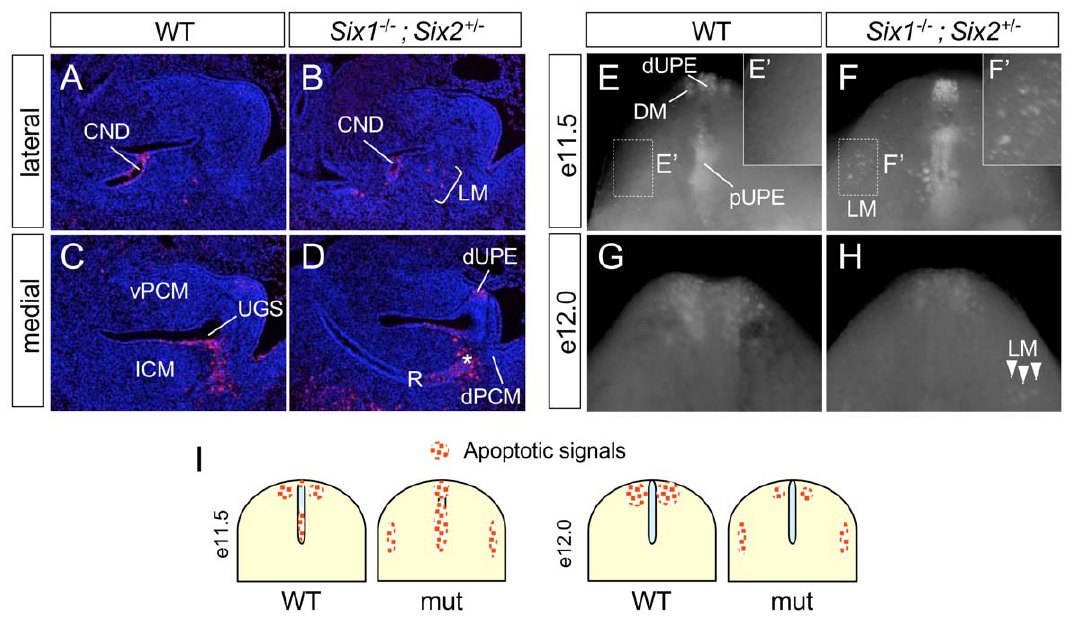
Figure 6. Six1;Six2 compound mutant genital tubercles have aberrant apoptosis patterns. ( A–D ) Comparable levels of serial of sagittal sections were stained with TUNEL for apoptotic cells (red). All sections were counter stained with DAPI (blue). ( E–H ) Ventral views of genital tubercles (GTs) stained with Lysotracker H for apoptotic cells (white dots). Apoptotic cells were observed in e11.5 control GTs within distal urethral plate epithelia (dUPE), proximal urethral plate epithelia (pUPE), distal mesenchymal (DM) (E). In Six1 2 / 2 ;Six2 + / 2 mutant, Lysotracker H signals were enhanced within dUPE and pUPE but not detectable within DM (F). Ectopic apoptotic cells in the lateral mesenchyme region (LM) was observed (E 9 , insert). At later stages, apoptotic cells were reduced in Six1 2 / 2 ;Six2 + / 2 mutants at e12.0 within DM (G and H). Ectopic cell death in LM persisted at e12.0 (arrowheads, H). ( I ) Schematic representations of dynamic changes of apoptosis patterns in control and mutants. CND, common nephric duct; distal mesenchymal (DM); LM, lateral mesenchyme; dUPE, distal urethral plate epithelium; pUPE; proximal urethral plate epithelium; R, rectum; see Fig. 1 for